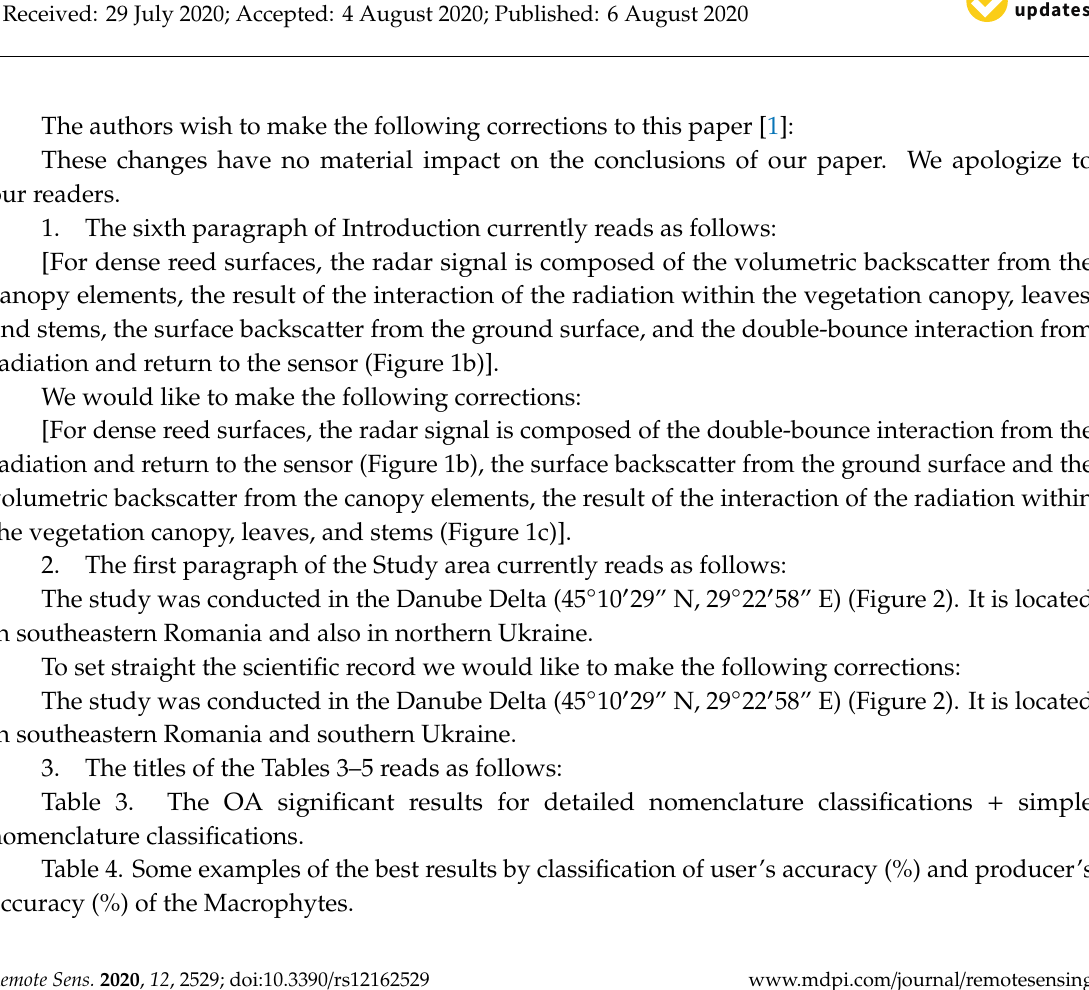
Table 4. Some examples of the best results by classification of user’s accuracy (%) and producer’s accuracy (%) of the